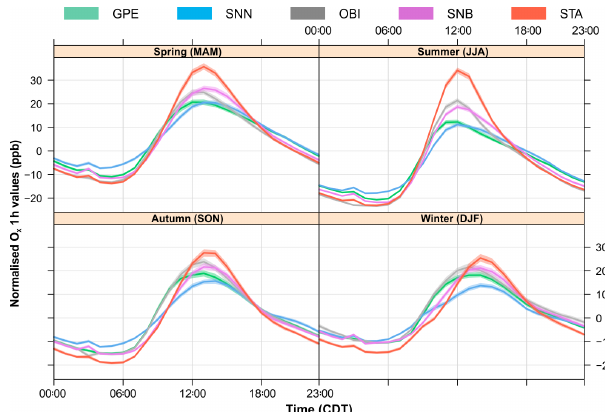
Figure 4. Seasonal O x de-trended daily profiles within the MMA during 1993–2014. De-trended O x daily cycles were constructed by subtracting daily averages from hourly averages to remove the impact of long-term trends.